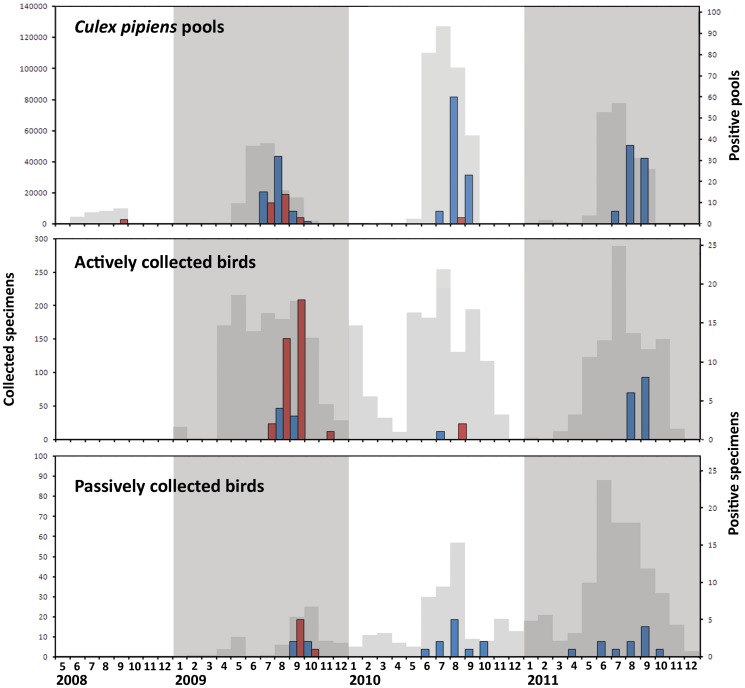
Number of collected (grey) and WNV-positive (red) and USUV-positive (blue) Culex pipiens pools, actively collected birds, and passively collected birds.